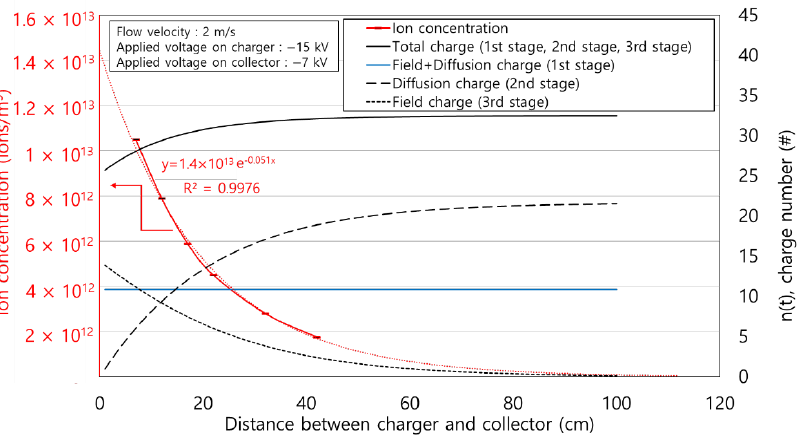
Figure 11. Obtained particle charge number at each stage according to the distance between the charger and collector using the modified charging model.